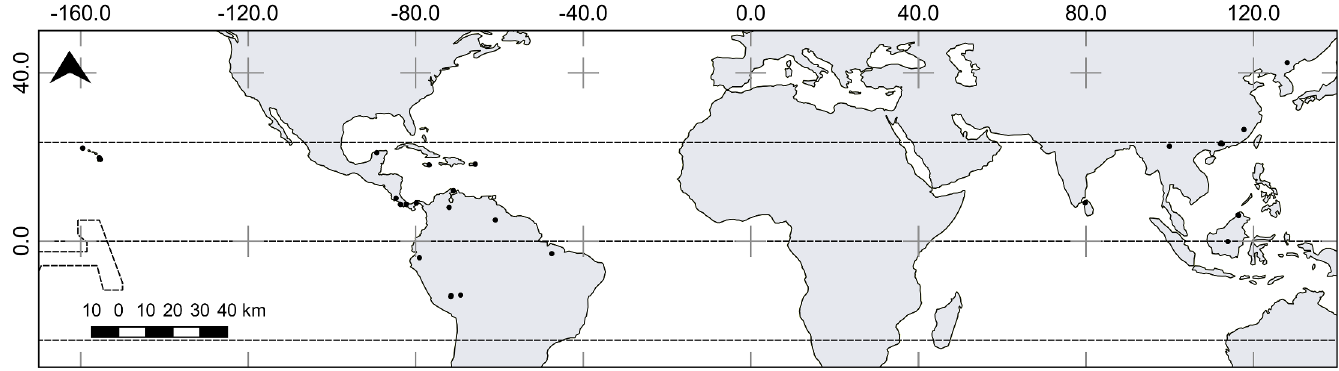
Fig 2. Localities included in the meta-analysis. Made with Natural Earth. Free vector and raster map data @ naturalearthdata.com.